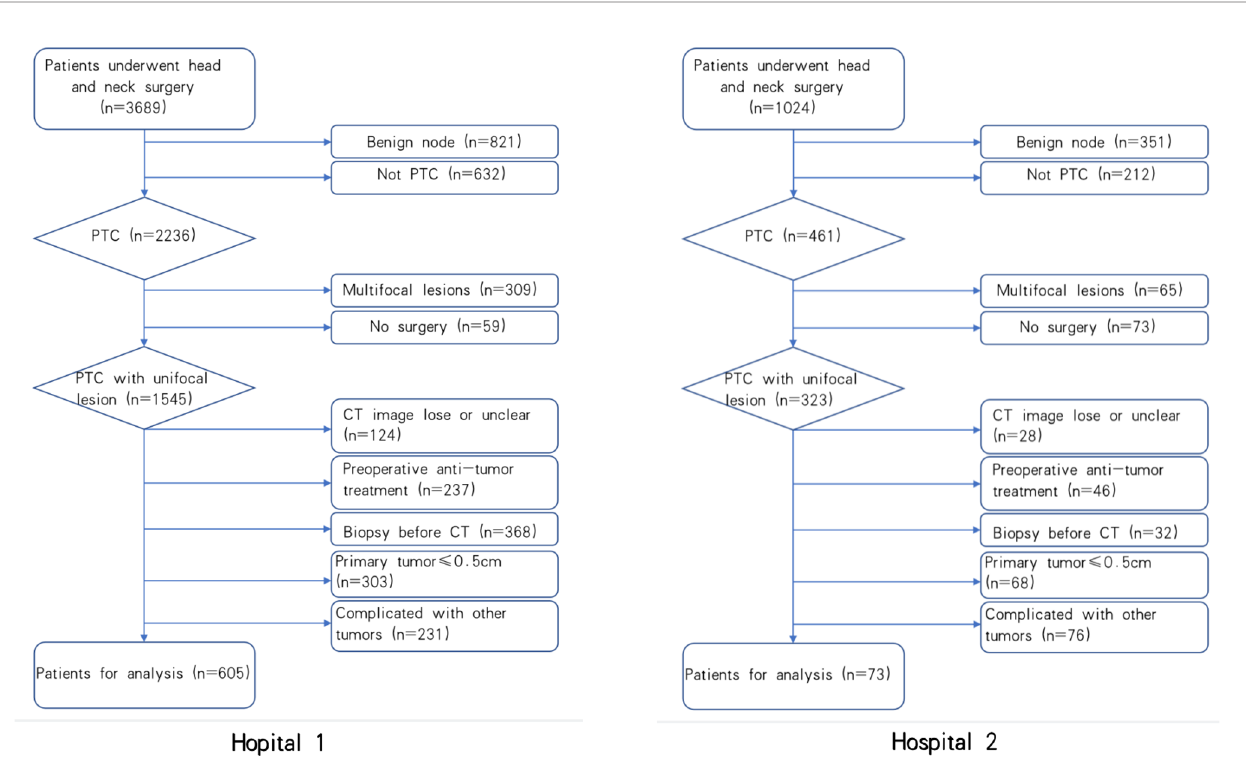
FIGURE 2 | The fl ow chart of patients Recruitment process. Hospital 1 stands for patients from Yantai Yuhuangding Hospital, Hospital 2 stands for patients from the Af fi liated Hospital of Binzhou Medical